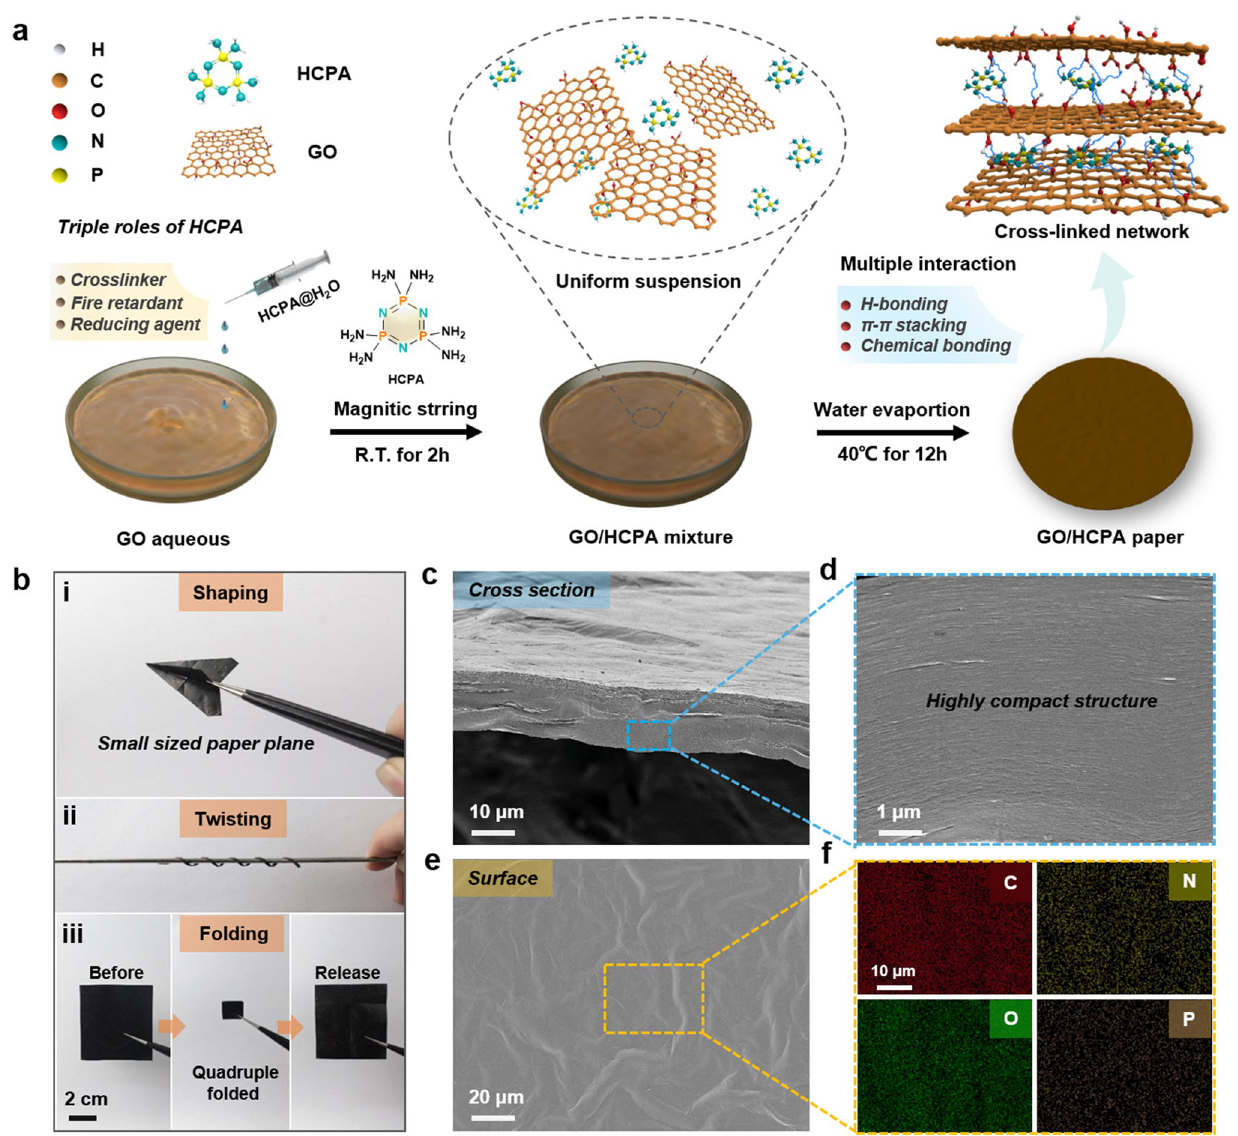
Fig. 1 Conceptual design, fabricating process and microstructure. a Scheme for preparing the GO/HCPA paper nanocomposites via a simple water evaporation‑induced self‑assembly strategy. b Digital photograph of GO/HCPA paper, the excellent mechanical strength and flexibility can make it withstand shaping, twisting and folding, and no cracks or damages are observed. Typical SEM images of GO/HCPA paper: c , d cross section and e , f surface and corresponding EDS mapping images for C, O, N and